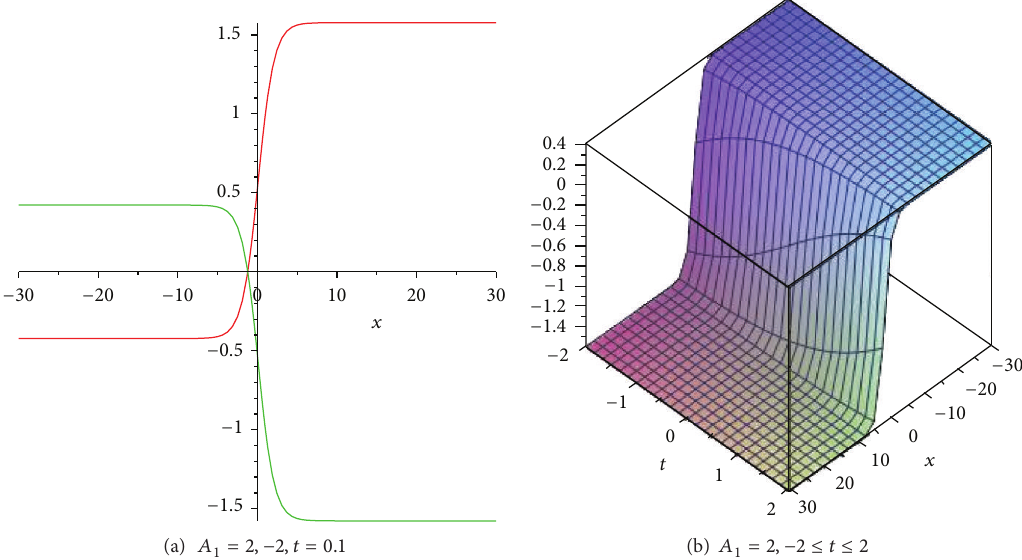
Figure 1: 2D and 3D figures of solution 𝜂 1 (𝜉) in (30) with 𝑎 = 1 , 𝑏 = 1 , 𝐶 1 = 1 , 𝜉 0 = 0 , 𝜌 3 = 0.1 , 𝛼 = 0.1 , and 𝛽 = 0.2 in the intervals 𝑥 ∈ [−30,30] .